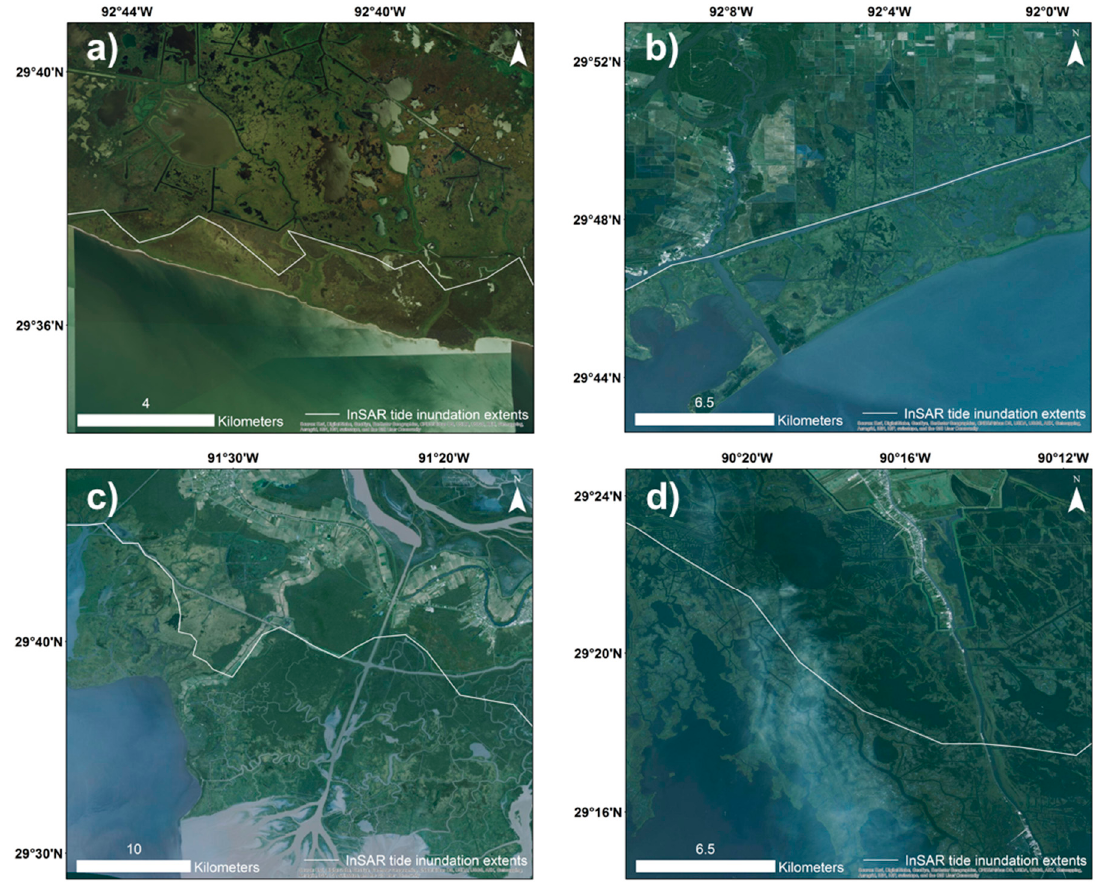
Figure 9. Zoom-in maps showing geographical features along the InSAR detected boundary of tidal inundation extents: ( a , b ) Chenier Plane; ( c ) central coast of Louisiana and ( d ) Timbalier bay, west of the Mississippi River delta. Satellite images source: Esri ArcGIS ® world imagery basemap.